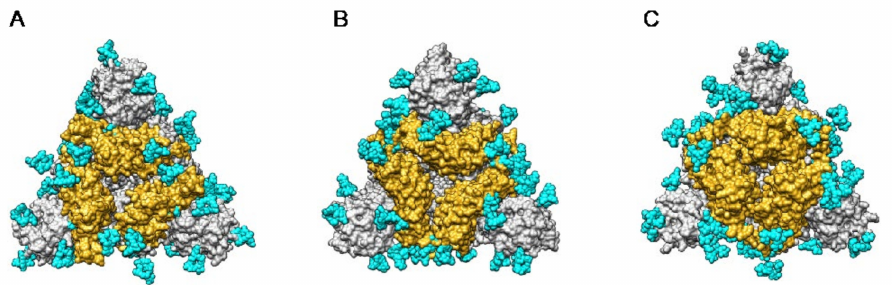
Figure 36. ( A – C ). Top face of the ribbon diagram of the homotrimeric spike of SARS-CoV (PDB code 6ACD) ( A ), MERS-CoV (PDB code 5W9H) ( B ), and SARS-CoV-2 (PDB code 6VXX) ( C ). High-mannose glycans and complex glycans are colored cyan. Molecular surfaces corresponding to the RBDs are colored gold and the remaining molecular surfaces are colored grey.